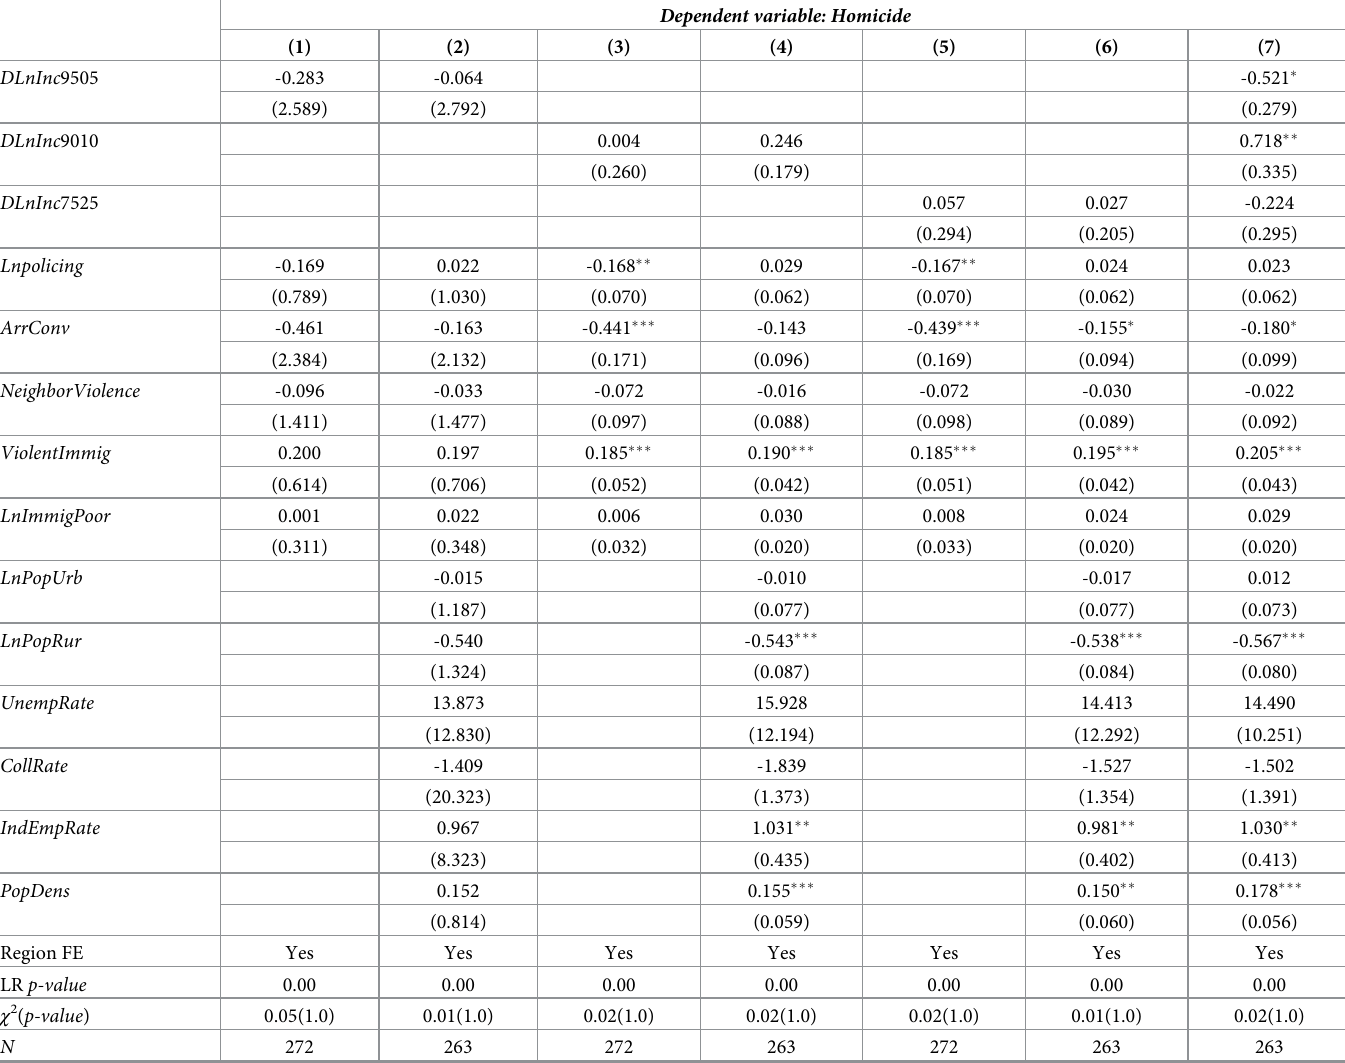
Table 2. The effect of income inequality on